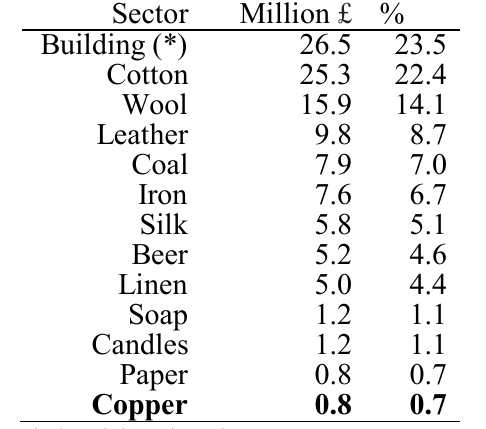
Table 1: value added per sector in British industry,